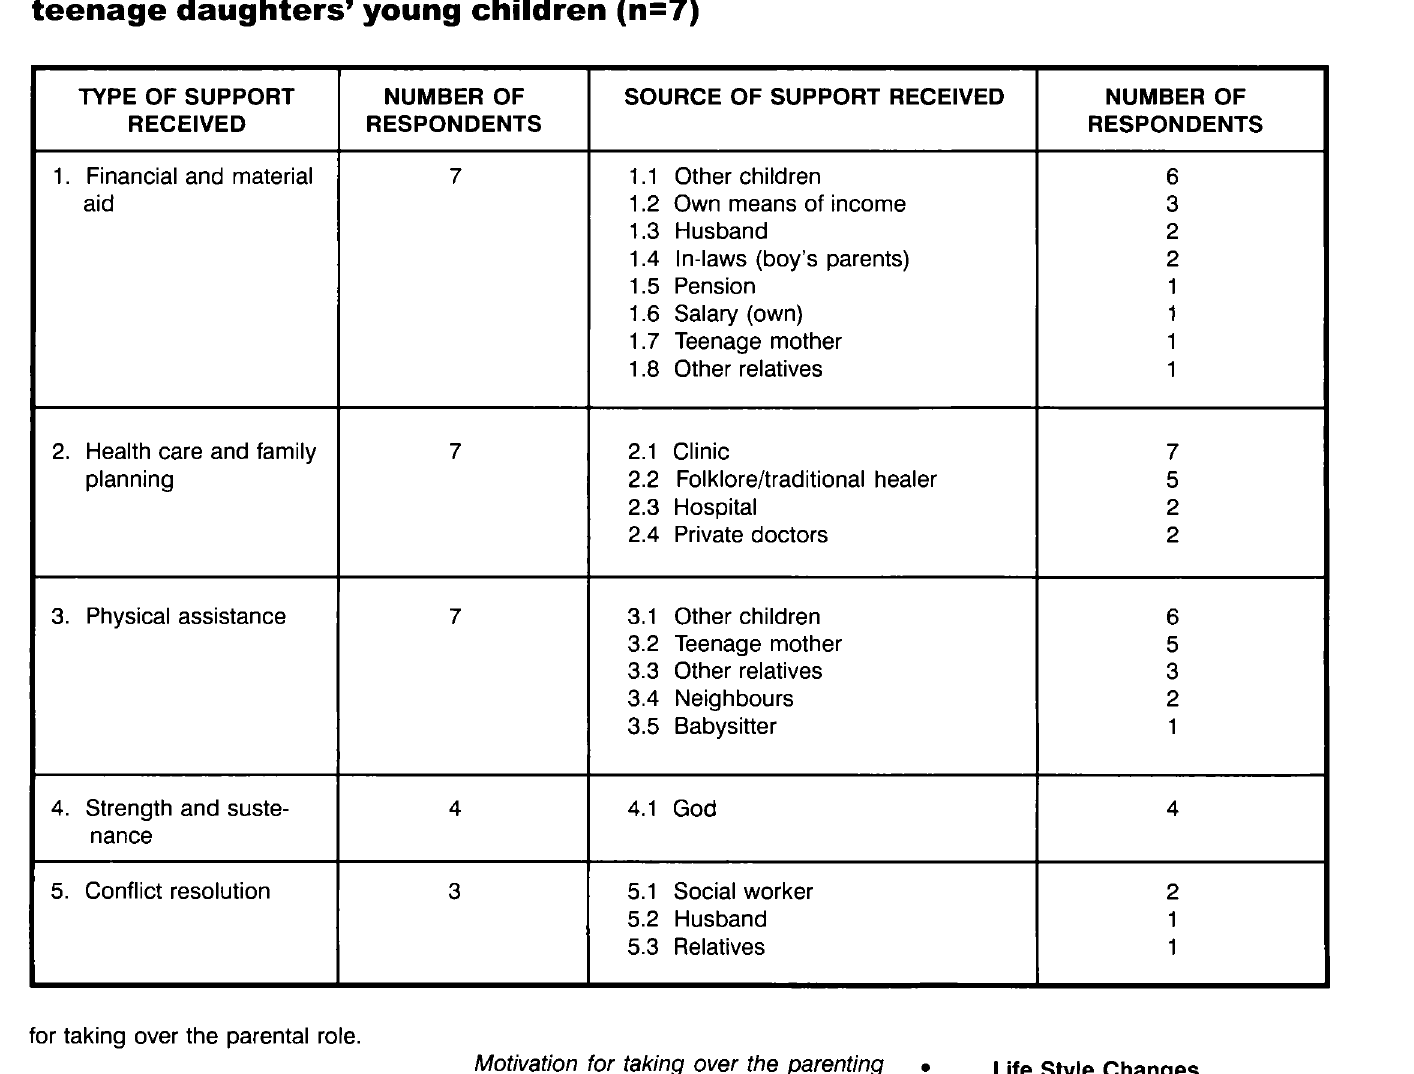
Table 3 : Type and sources of support received by mothers caring for their teenage daughters’ young children